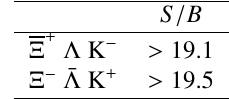
Table 5. Signal-to-Background